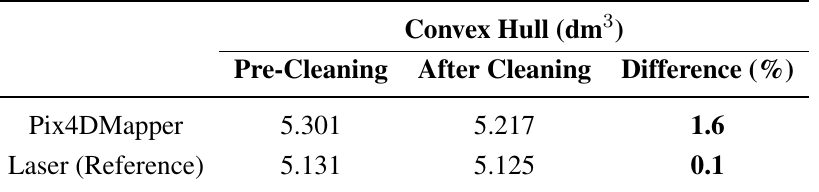
Table 2. Example of the influence of cleaning on the convex